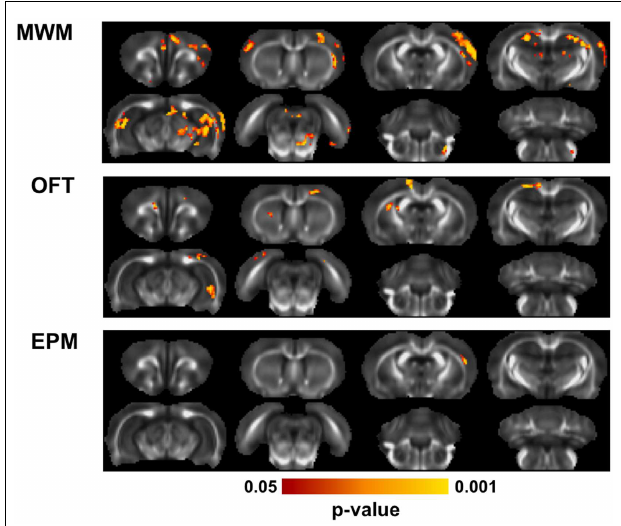
FIGURE 7 | Diffusion tensor imaging correlations with behavior . Across all animals exposed to blast, multiple linear regression was used to determine whether behavioral outcomes were associated with brain microstructure. For each behavioral test, the outcome measures obtained from it were regressed against the FA value from all animals using a F -test, controlling for blast severity and DPI. In the MWM, FA was significantly related to behavioral performance in the hippocampus and portions of the motor cortices. In the OFT, a region of the ventral hippocampus and region of the external capsule were significantly related to the behavioral performance.The EPM was related to FA in only a small region of the contralateral